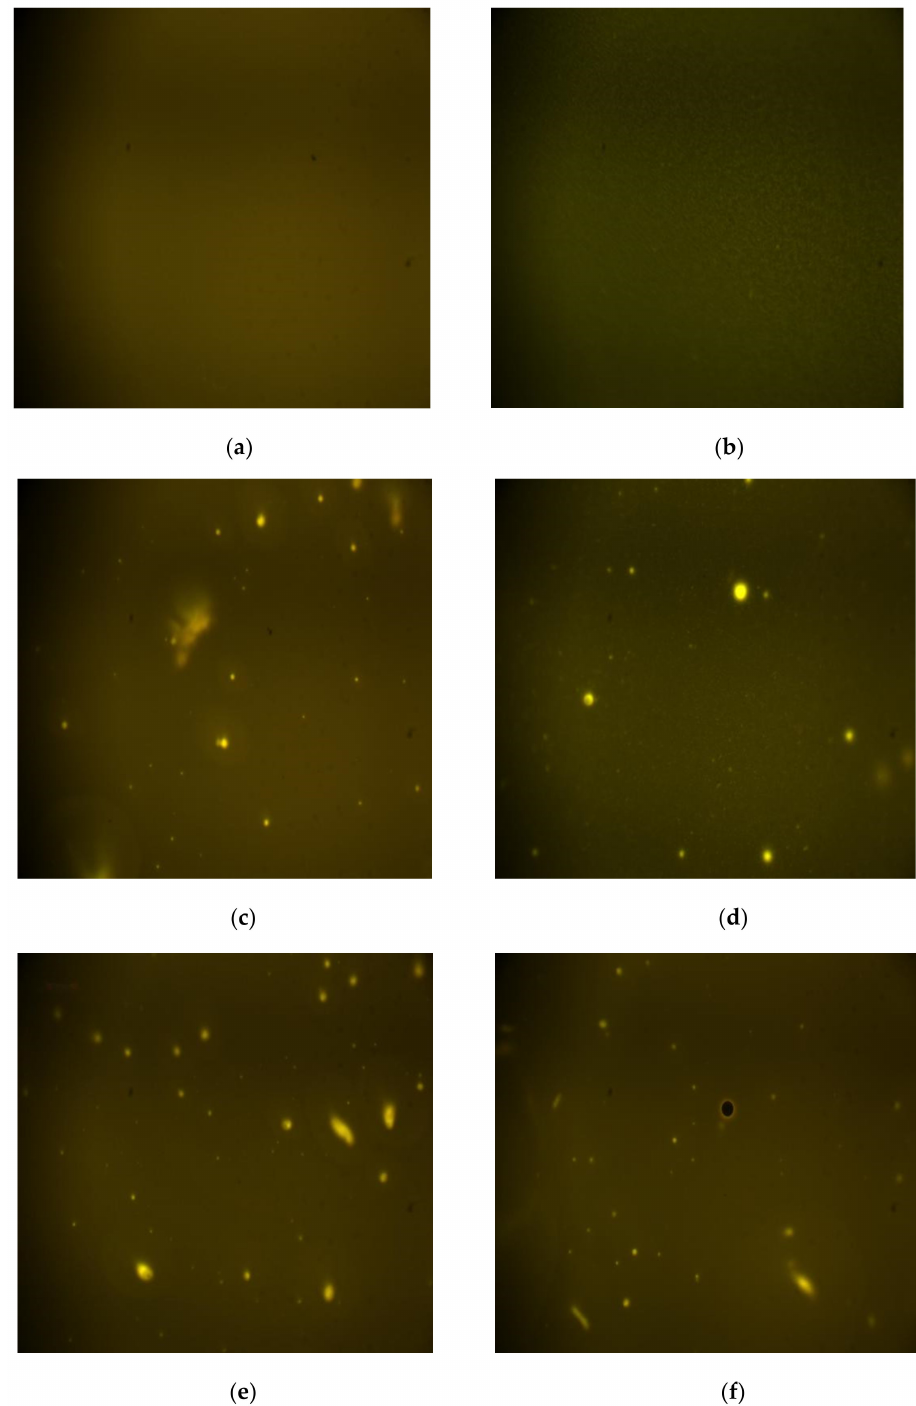
Figure 3. The morphology of asphalt samples before and after modification (magnified by 400 times). ( a ) pure matrix asphalt; ( b ) pure SBS − modified asphalt; ( c ) matrix asphalt with 4 wt% PCM; ( d ) SBS − modified asphalt with 4 wt% PCM; ( e ) matrix asphalt with 8 wt% PCM; ( f ) SBS − modified asphalt with 8 wt%